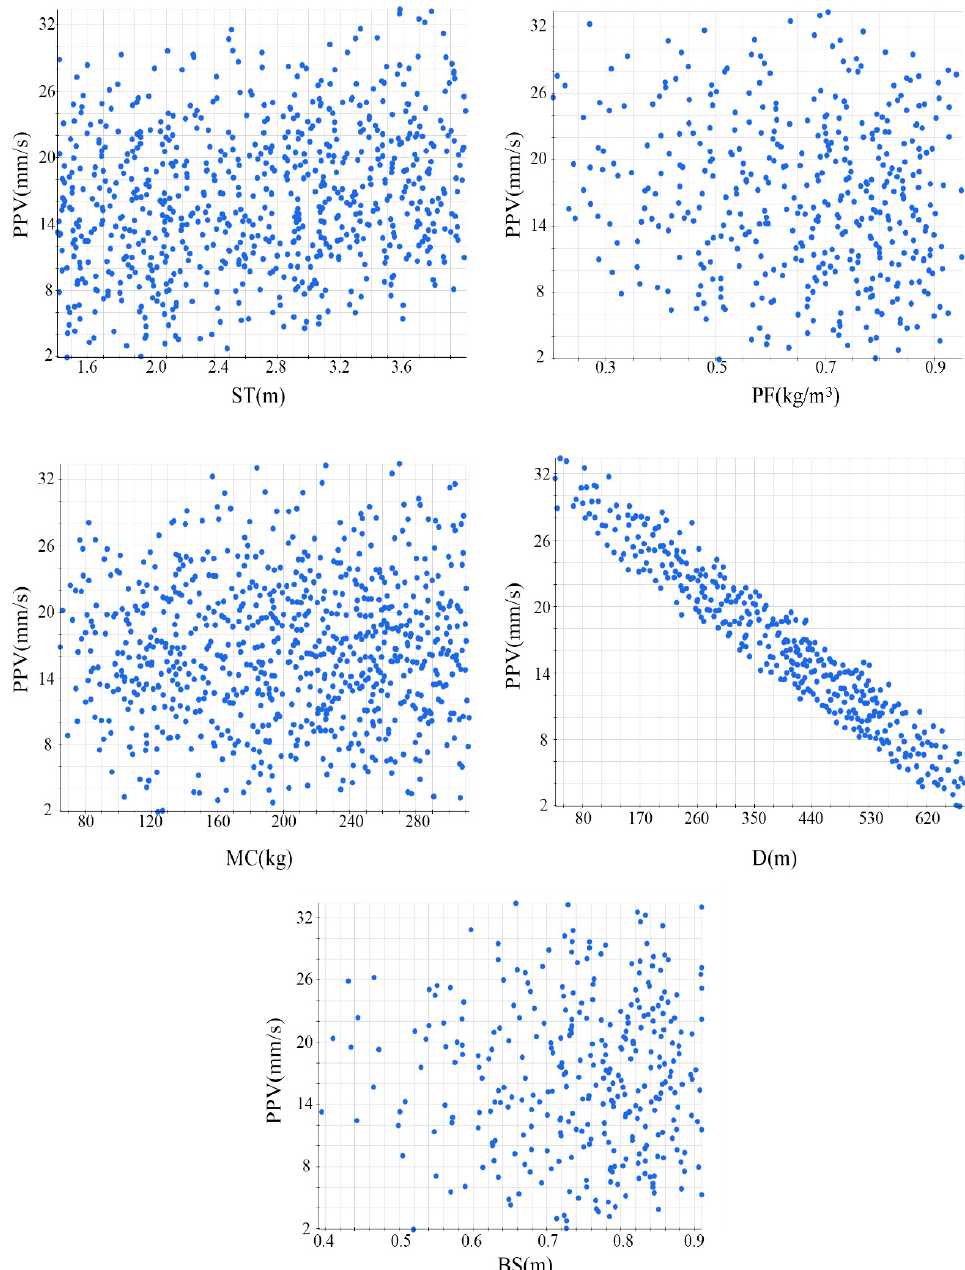
Figure 9. Scatter results of each input against PPV obtained by Monte Carlo simulation.